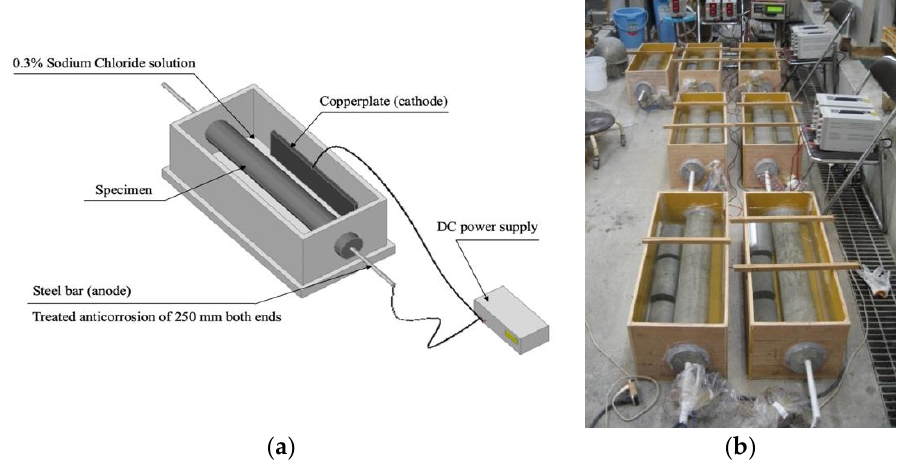
Figure 5. Accelerated corrosion system: ( a ) schematic of accelerated corrosion tests; ( b ) specimens under accelerated corrosion.